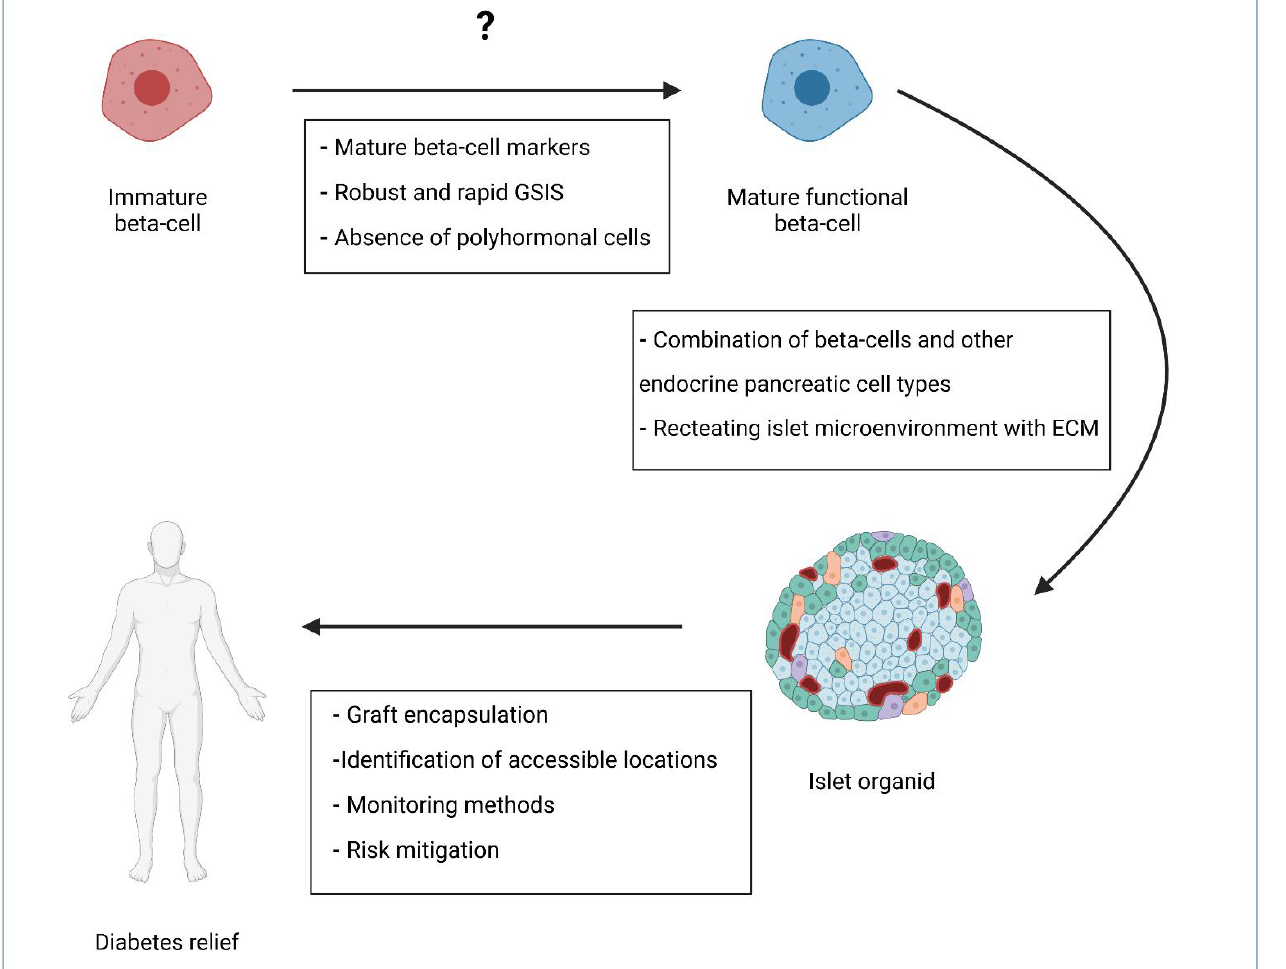
Figure 1. Further steps in cell-based diabetes treatment. Generation of fully mature insulin-producing cells that are functionally identical to native beta cells is the first stage. The next one could be the combination of beta cells with supporting cells and encapsulation of such islet organoids. The final stage would be finding the best transplantation method with minimal risks. GSIS—glucose-stimulated insulin secretion; ECM—extracellular matrix. Created with BioRender.com.